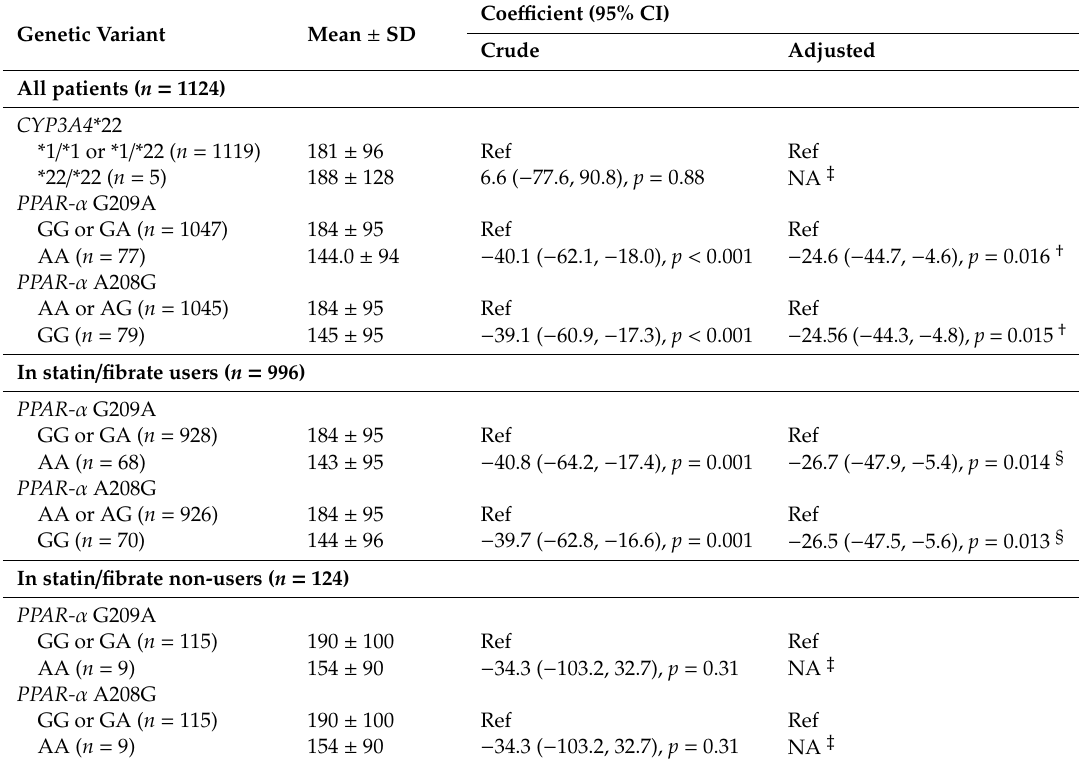
Table 2. On-treatment platelet reactivity in carriers of recessive alleles of CYP3A4 *22 , PPAR- α G209A, and PPAR- α A208G.